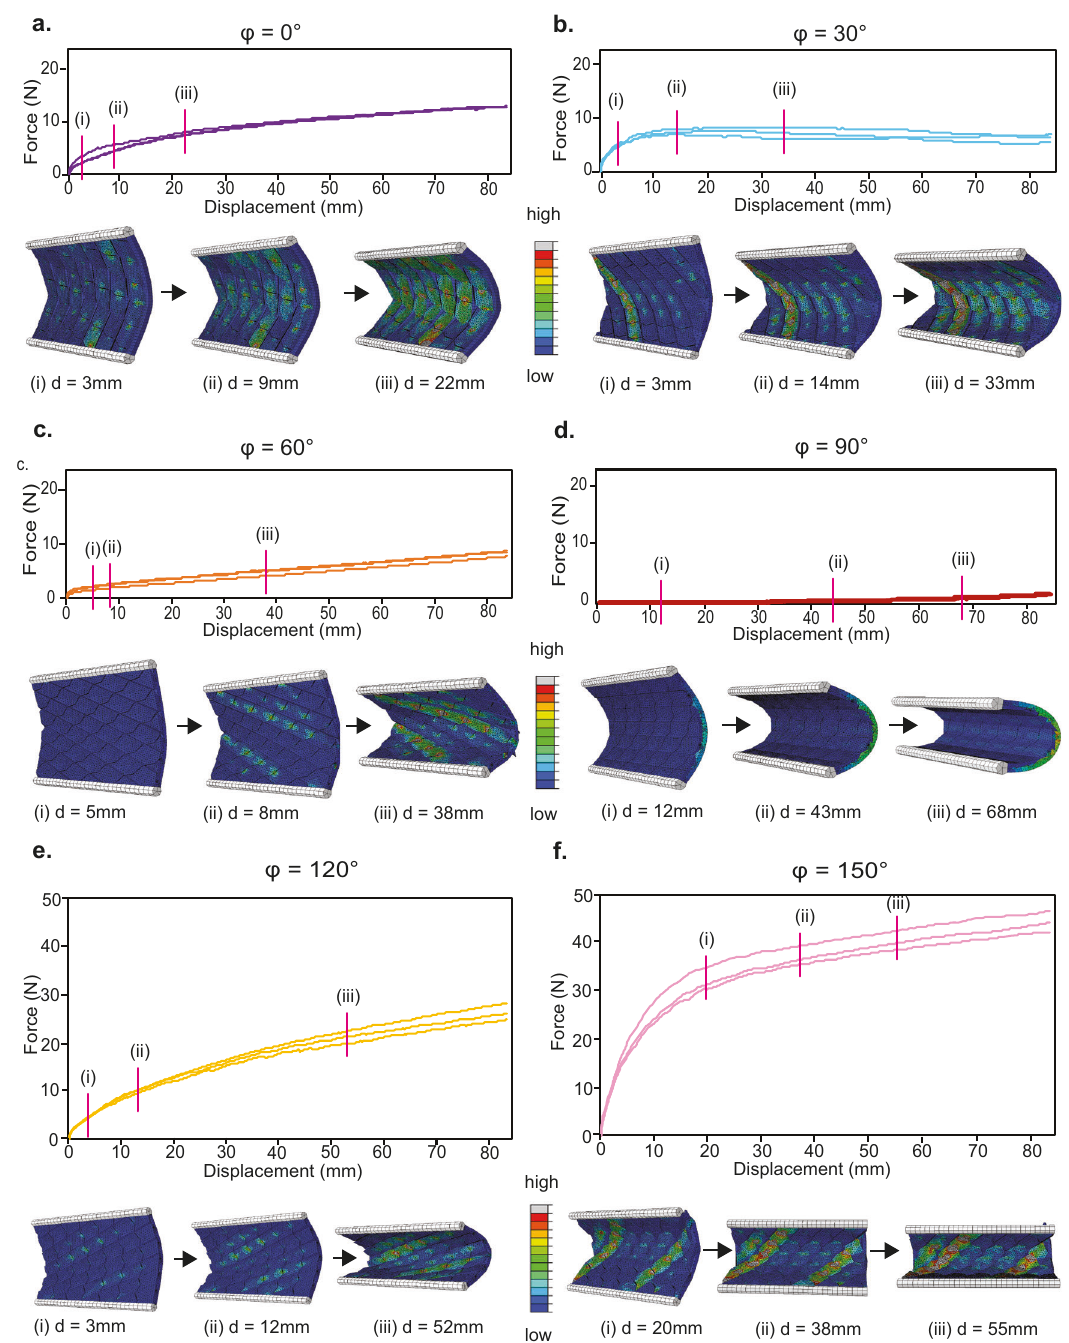
Fig. 5 Orientation-dependent bending behavior of the scaled prototypes. a Experimental bending of the prototype with φ = 0°. Stress plots (Mises, linear elastic) from the FE simulation of the φ = 0° model. (i) Front view at d = 3 mm, (ii) d = 9 mm, and (iii) d = 22 mm. b Experimental bending of the prototype with φ = 30°. Stress plots, front view at (i) d = 3 mm, (ii) d = 14 mm, and (iii) d = 33 mm. c Experimental bending of the prototype with φ = 60°. Stress plots, front view at (i) d = 5 mm, (ii) d = 8 mm, and (iii) d = 38 mm. d Experimental bending of the prototype with φ = 90°. Stress plots, front view at (i) d = 12 mm, (ii) d = 43 mm, and (iii) d = 68 mm. e Experimental bending of the prototype with φ = 120°. Stress plots, front view at (i) d = 3 mm, (ii) d = 12 mm, and (iii) d = 52 mm. f Experimental bending of the prototype with φ = 150°. Stress plots, front view at (i) d = 20 mm, (ii) d = 38 mm, and (iii) d = 55